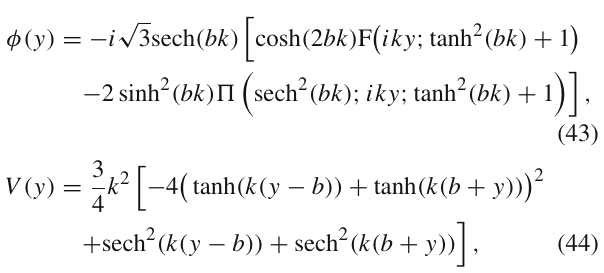
resonances by using large peaks in the distribution of the normalized squared wavefunction [28]. But this method is only applicable to even functions, and it is no longer valid when the solutions are odd. In order to find all resonances, Liu et al. proposed another method by defining the relative probability